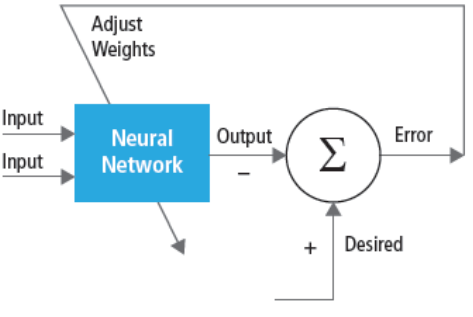
Fig. 5. Training of neural